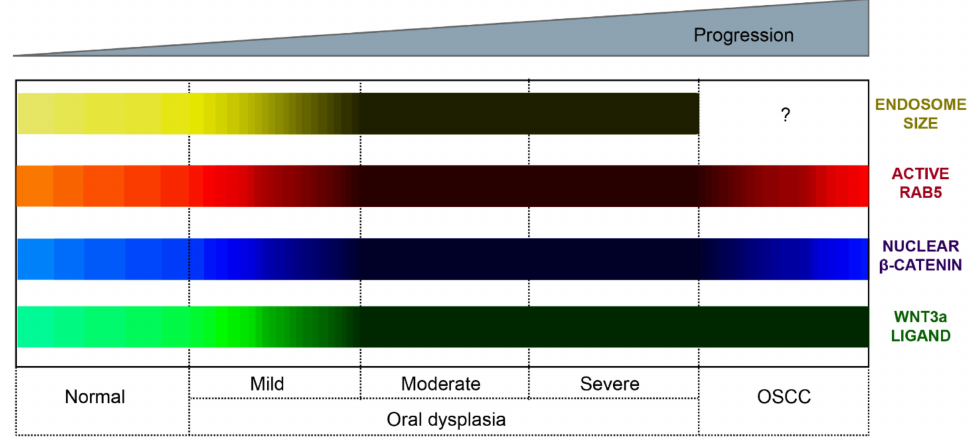
Figure 6. Subcellular and molecular events in oral carcinogenesis. This scheme provides a summary of subcellular and molecular changes observed during oral carcinogenesis. These changes include the Wnt3a expression, nuclear detection of β -catenin, endosome enlargement and the activation status of Rab5 GTPase. We propose a model whereby oral carcinogenesis is associated with the progressive expression of Wnt3a and the consequent stabilization and nuclear translocation of β -catenin. These events are accompanied by the continuous activation of Rab5-GTPase, endosome enlargement and the increased sequestration of the destruction complex within endosomes (see main text for details). Color codes represent the Wnt3a expression (green bar), nuclear β -catenin detection (blue bar), Rab5 activity (red bar) and early endosome size (yellow bar). The lighter the color, the lower the expression / detection / activity / size. The darker the color, the higher the expression / detection / activity / size for each case. The Wnt3a representation summarizes evidence obtained from immunohistochemical analyses in clinical samples and in vitro measurements of ligand secretions in cell culture models. The nuclear β -catenin representation summarizes evidence obtained in both clinical samples and cell culture models. The nuclear detection progressively increases from normal oral mucosa through the di ff erent stages of oral dysplasia (mild, moderate and severe); however, the nuclear detection of this protein decreases in OSCC. The Rab5 activity (Rab5-GTP levels) has been measured in cell culture models and is shown substantially increased in dysplastic oral keratinocytes (models of moderate / severe dysplasia) in comparison with nondysplastic oral keratinocytes and OSCC cells. The endosomal size (early endosomes) has been measured by tissue immunofluorescence in clinical samples of normal mucosa and mild, moderate and severe dysplasia, as well as in cell culture models, using di ff erent markers of early endosomes (the interrogation symbol indicates that this has not been explored in